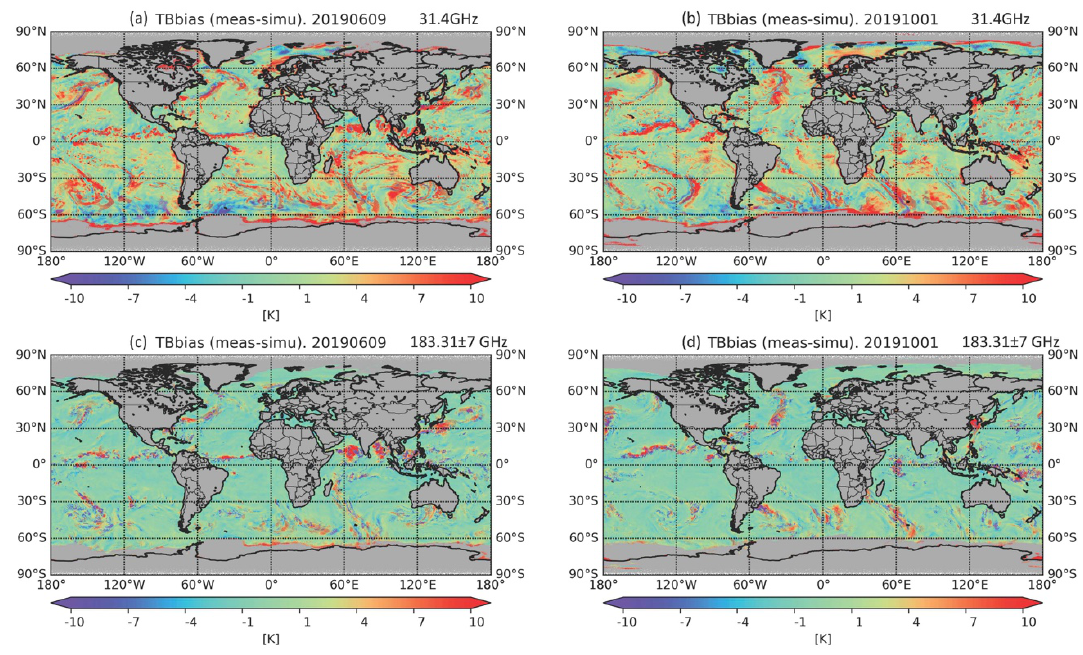
Figure 2. Global brightness temperature measurements minus simulations [K] over ocean, for 9 June 2019 at 31.4 GHz and 183.31 ± 7 GHz frequencies ( a , c ), and similarly for 1 October 2019 ( b , d